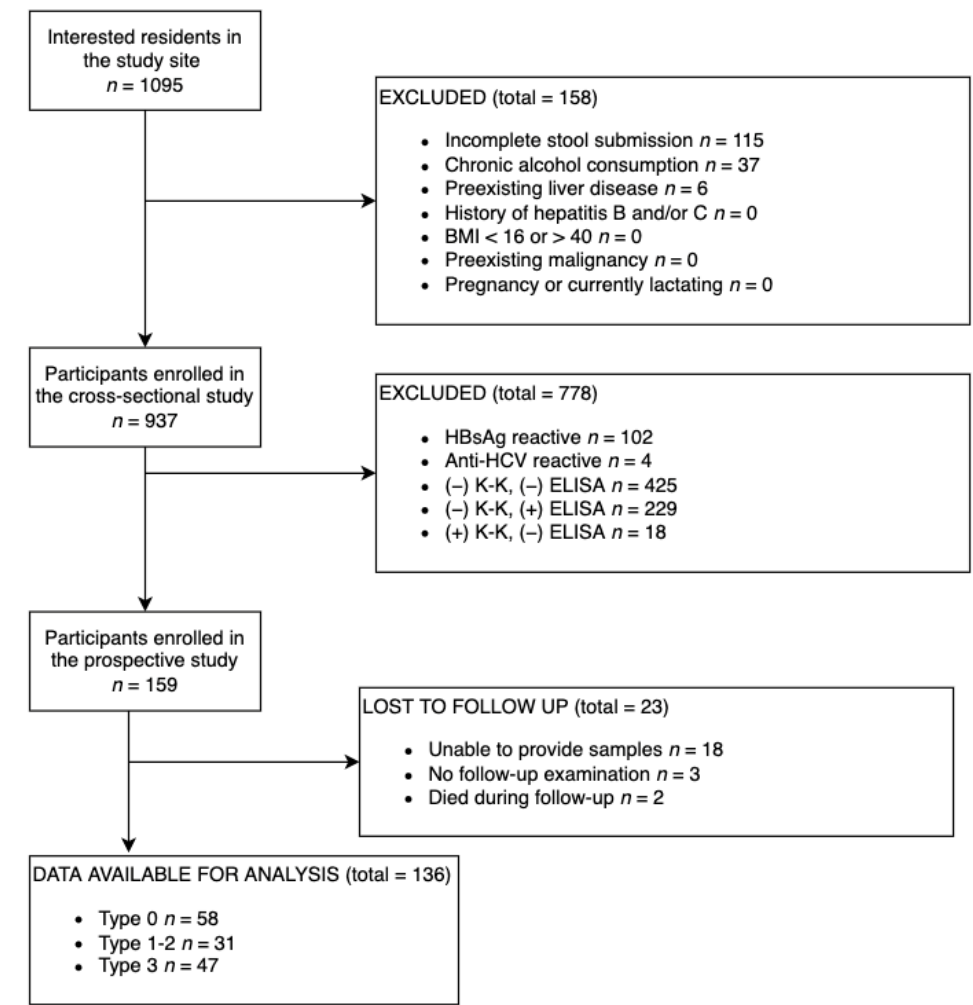
Figure 1. Participant recruitment and follow-up flow diagram.